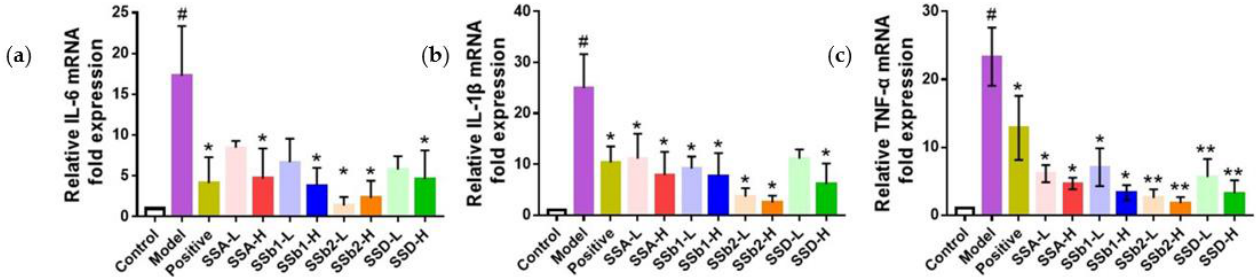
Figure 7. Effects of SSA, SSb1, SSb2, and SSD on mRNA expression levels of IL-6 ( a ), IL- 1β ( b ), and TNF- α ( c ) in lung tissues from LPS-induced ALI mice ( n = 3, means ± SD s). Analyzed using a one-way ANOVA. # p < 0.05 vs. control group; * p < 0.05, ** p < 0.01 vs. LPS-induced model group. 2.6. SSs Decreased the Expression of TLR4 and NF- кB in the Lung s of ALI Mice